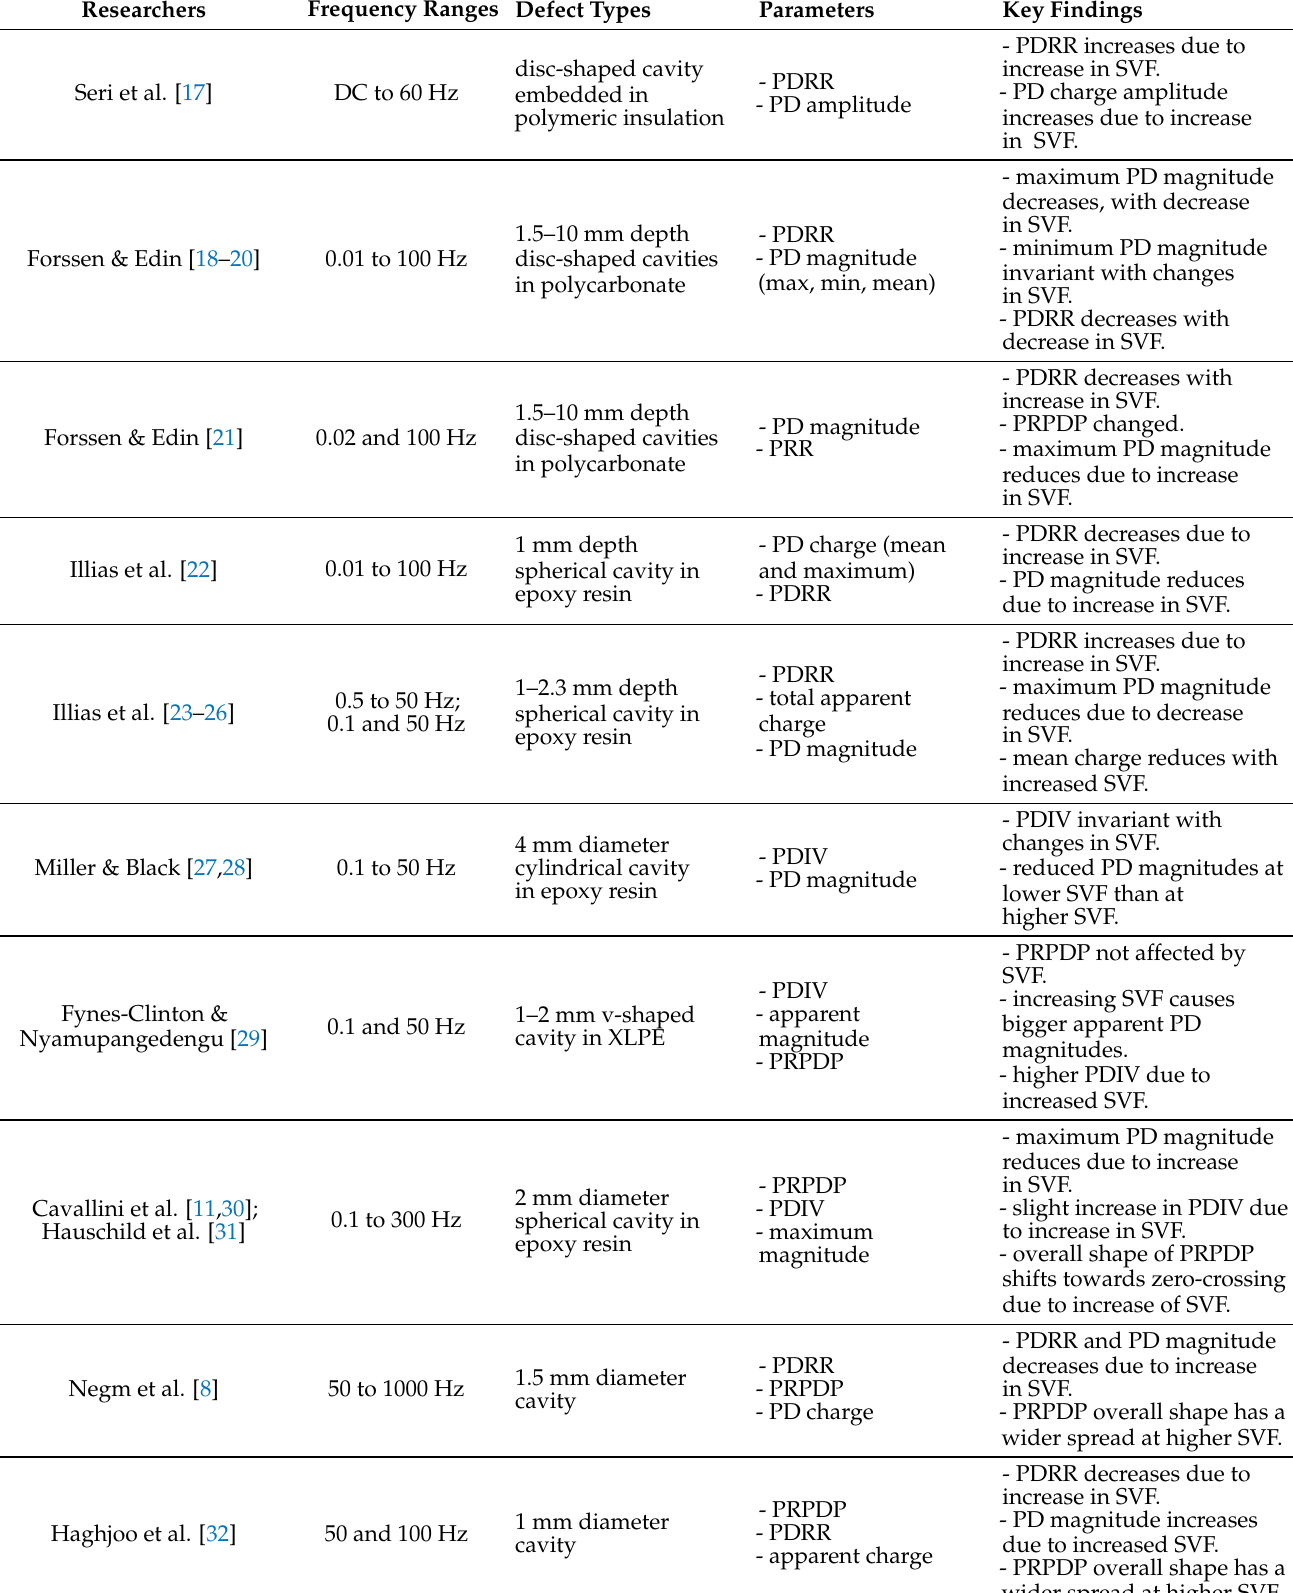
Table 1. Key findings in the literature on the effect of supply voltage frequency on cavity PD characteristics